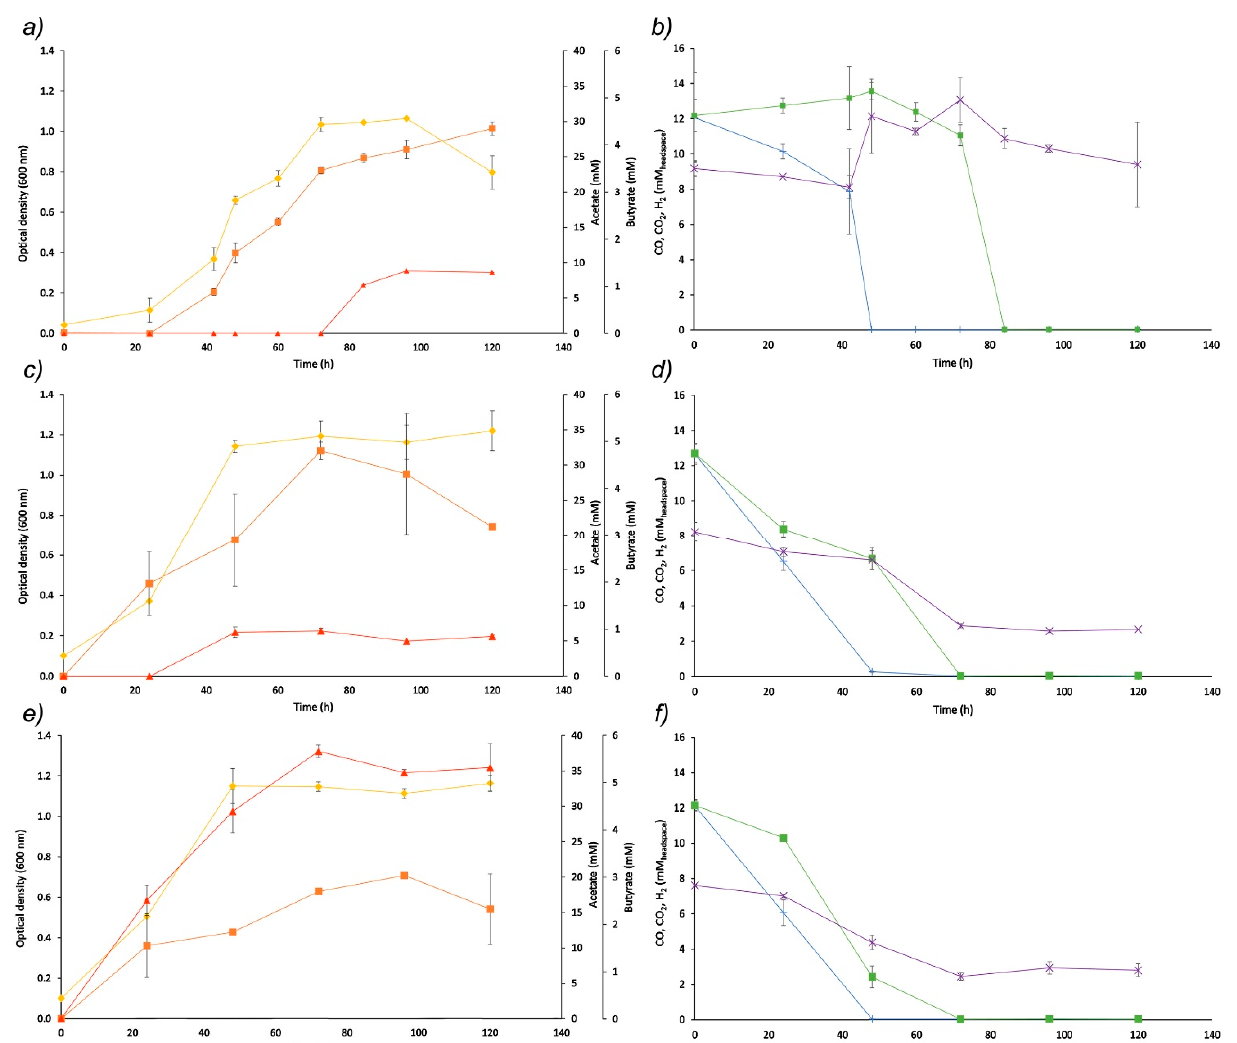
Figure 1. Cell growth, acetate and butyrate production, and CO, CO 2 and H 2 fixation by B. methylotrophicum cultured with Syngas A in serum flasks at: pH 7.0 ( a , b ); pH 6.0 ( c , d ); and pH 6.0 with supplementation of sodium acetate ( e , f ). The results are average values of two experiments. Standard deviation was performed with 3 experimental repetitions. ( —Opti- cal density at 600 nm; Table 2. Growth rate, acetate and butyrate production, pH and pressure decrease achieved in the culture of B. methylotrophicum with Syngas A, at pH 7.0 and pH 6.0, with or without medium sup- plementation of the culture medium with sodium acetate.